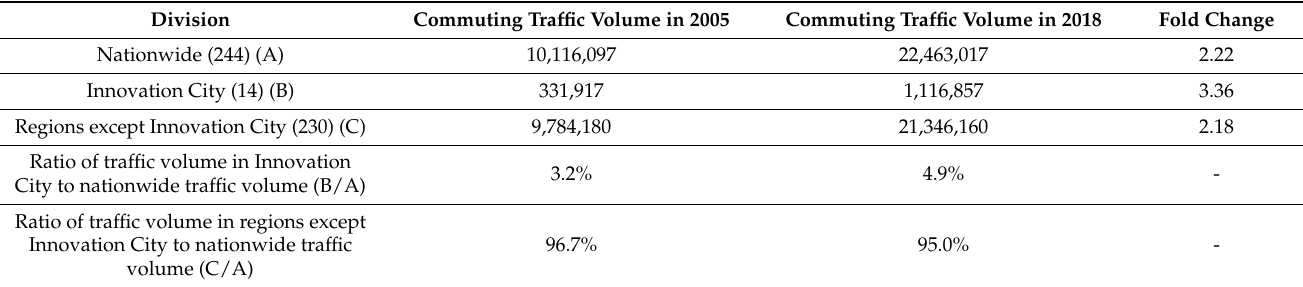
Figure 3. Degree centrality and eigenvector centrality of nationwide cities and districts. Table 3. Total commuter volumes across regions and in IC cities for 2005 and